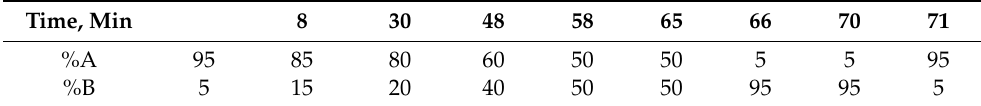
Table 1. HPLC analysis elution program. Eluent A: 1% trifluoroacetic acid; eluent B: 100% acetonitrile. Time,